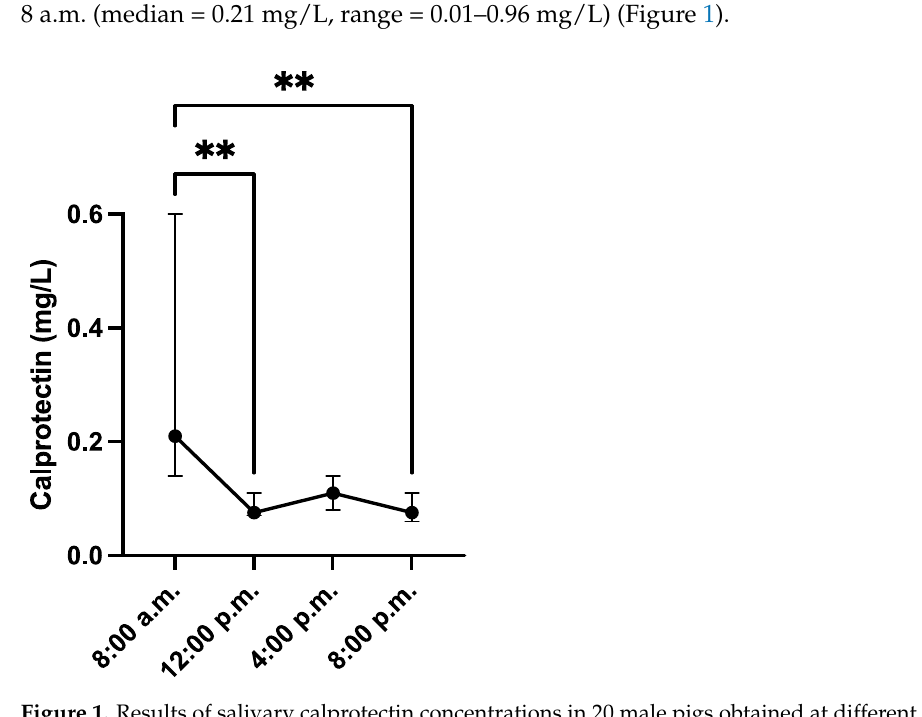
Figure 1. Results of salivary calprotectin concentrations in 20 male pigs obtained at different hours of the day. ** p -value < 0.01. Dots are representing median values and whiskers the 95% CI.